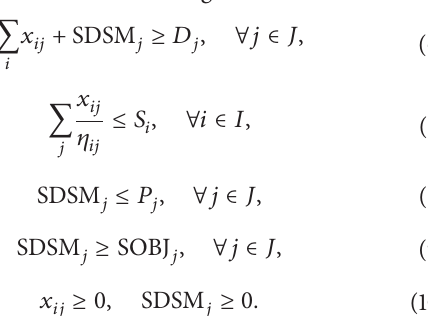
Table 1: Parameter values for renewable energy